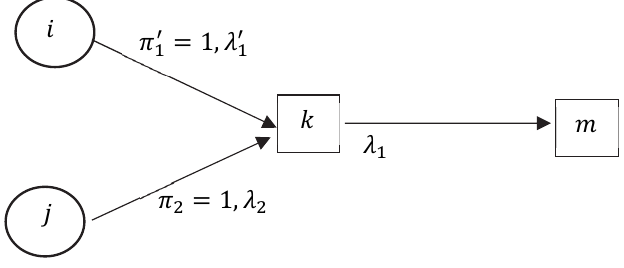
Fig. 2 . Jackson network under study in the proposed